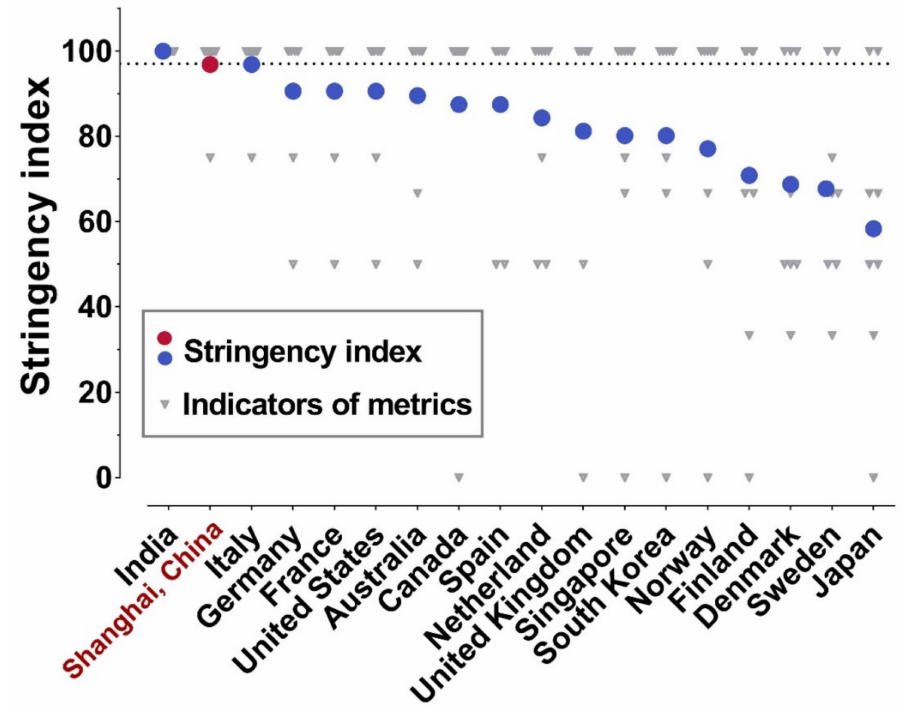
Figure 1. Stringency indices of lockdown policies implemented by different governments. Based on the Oxford Coronavirus Government Response Tracker project, the lockdown policies of different governments were assessed considering eight metrics (plotted as grey triangles). The stringency indices of lockdown policies were then derived from the eight metrics and presented as red/blue